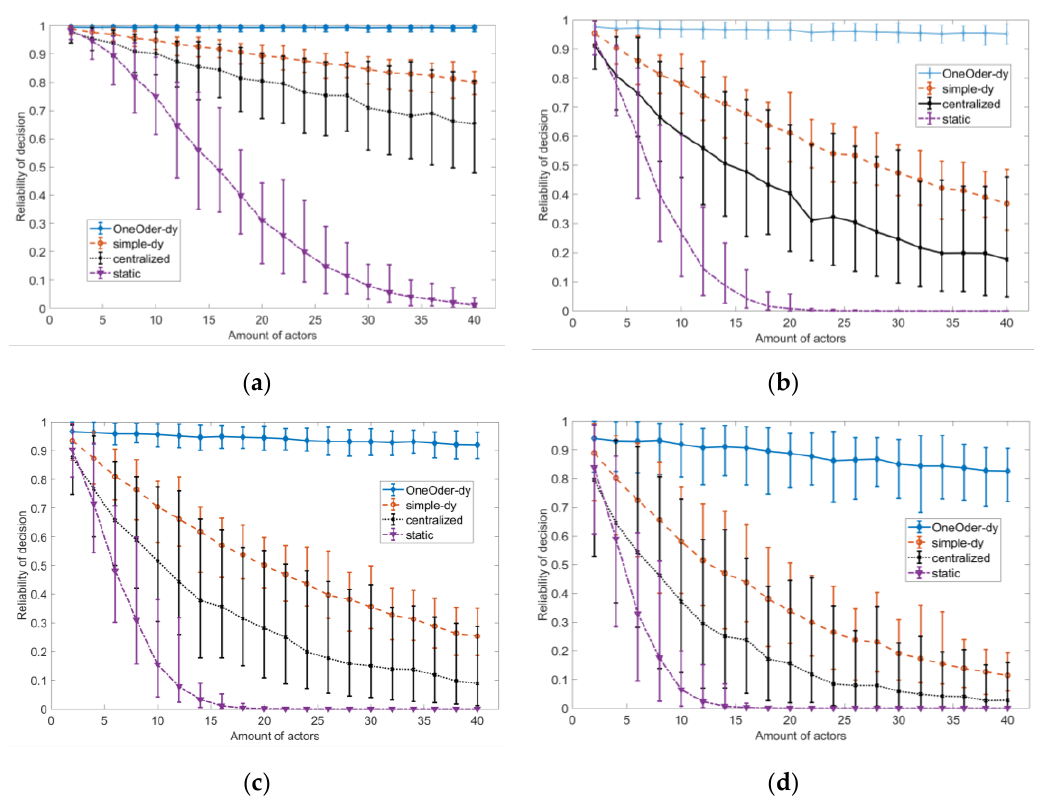
Figure A4. The reliability over different ranges of process time. ( a ) The reliability over the time range [10, 100]; ( b ) The reliability over the time range [200, 300]; ( c ) The reliability over the time range [300, 400]; ( d ) The reliability over the range [100, 1000].